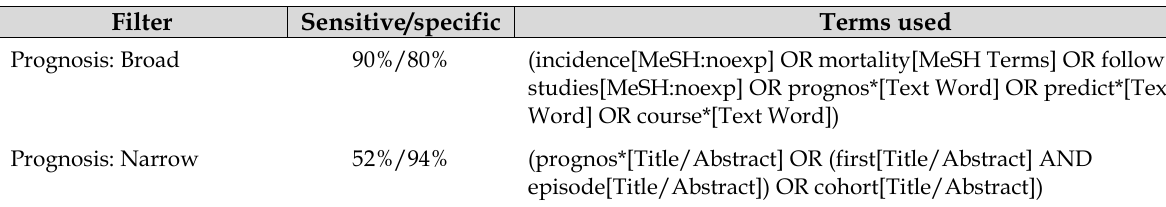
Table 1 Clinical query for “Prognosis” Filter